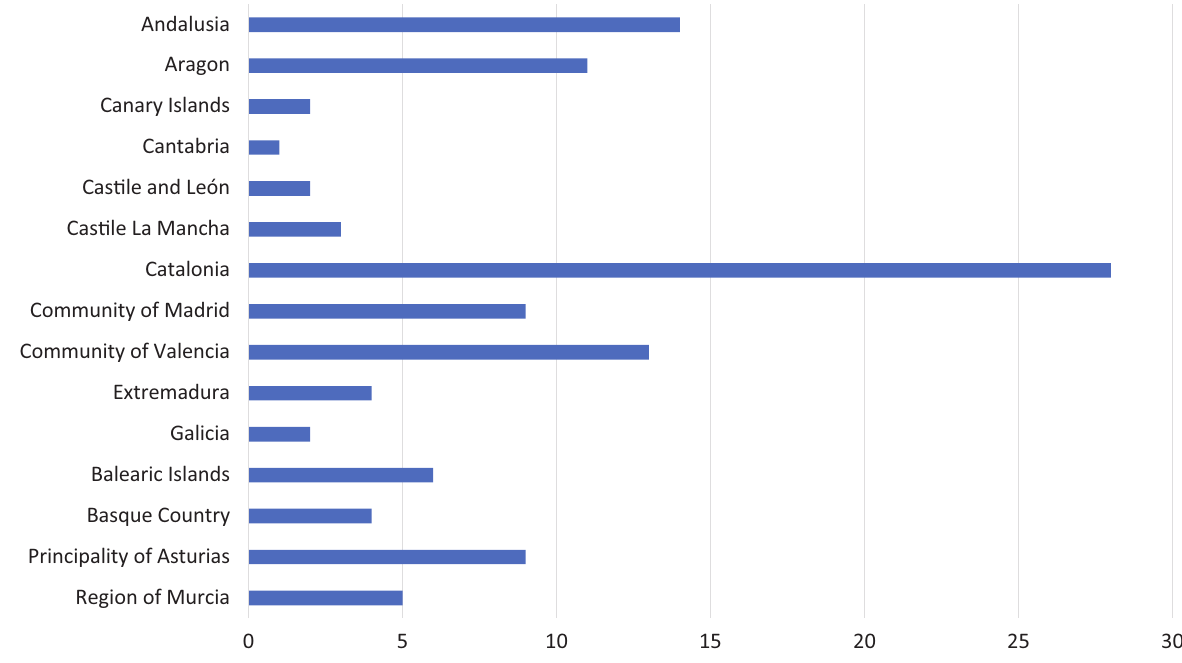
Figure 1. Number of questionaries collected by regions